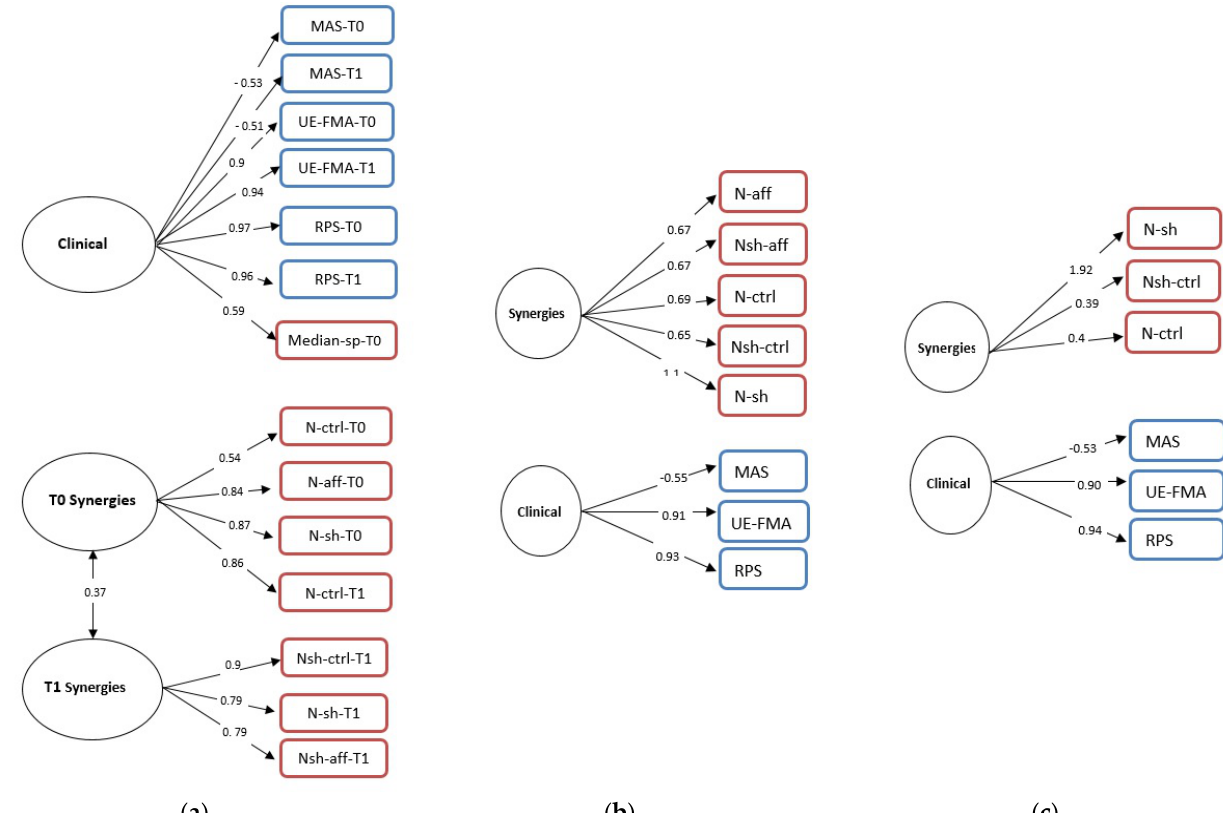
Figure 2. Confirmatory factor analysis for all variables ( a ) at T0 ( b ) and at T1 ( c ). Single-headed arrows indicate direct relationships. The numbers on each represent standardized factor loadings ranging from 1.0 to − 1.0. Squares represent measured variables and circles represent latent factors. The figures in blue represent the clinical variables, while those in red represent the synergies parameters. The double-headed arrows represent correlations between the factors.